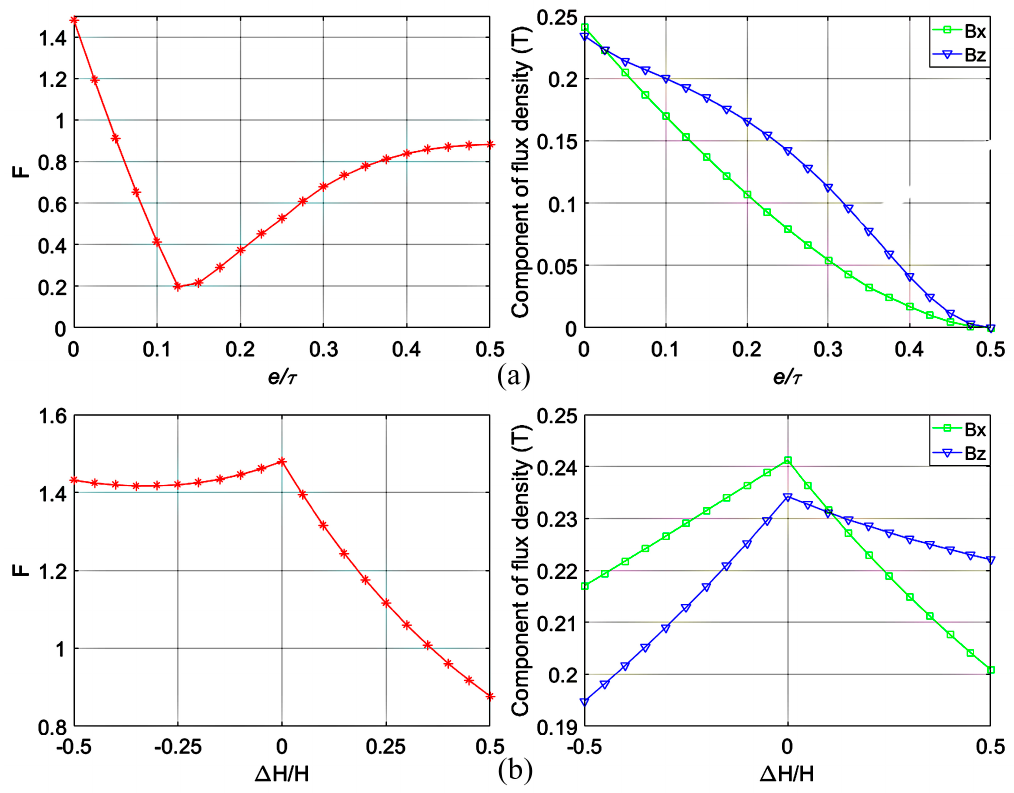
Figure 4. The influences on magnetic field characteristics ( a ) by varying e / τ when ∆ H / H takes 0, and the width ratio of two kinds of magnets ( c / d ) kept as 0.68:0.32 and ( b ) by varying ∆ H / H when e / τ takes 0.